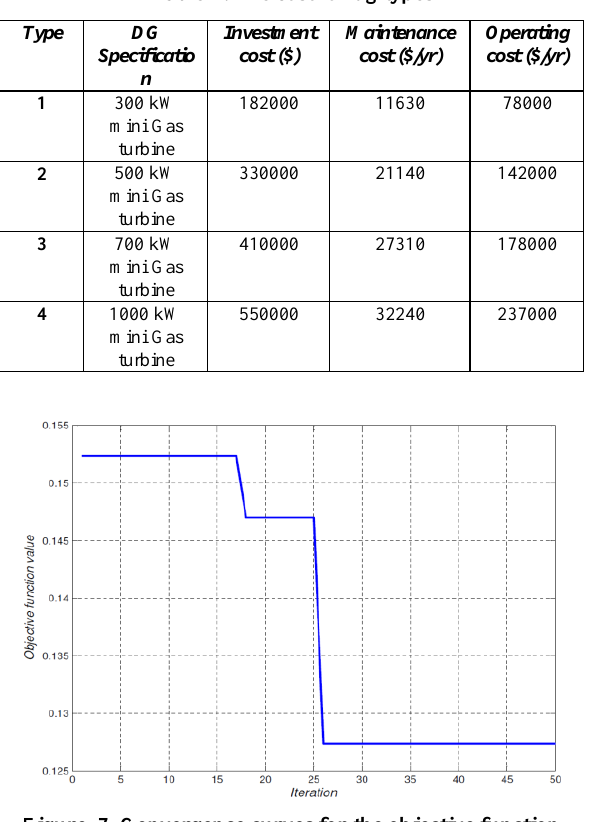
Figure .7. Convergence curves for the objective function with MSFLA